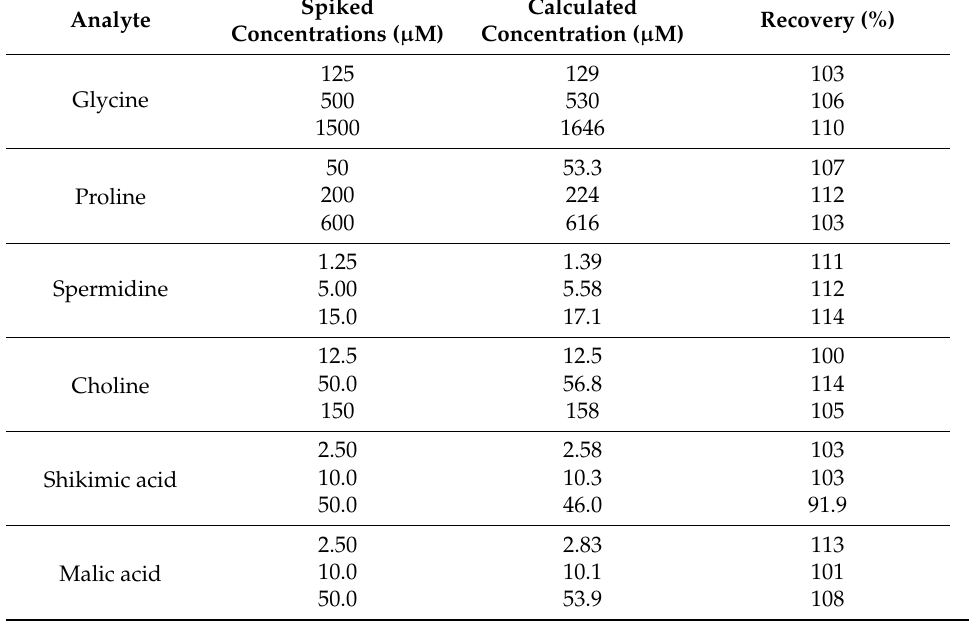
Table 4. Recovery Performance of Representative Analytes in Spiked NIST ® SRM ® 1575a Pine Needle